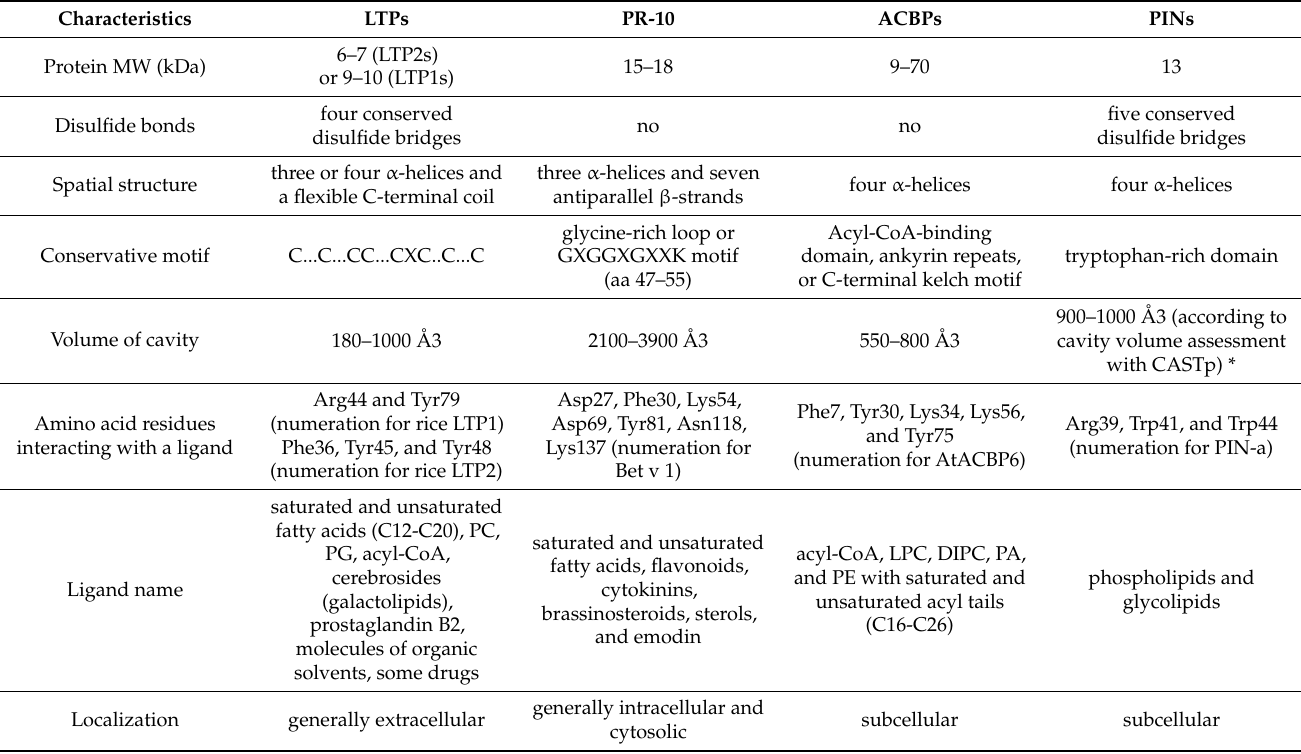
Table 1. Comparison of structure–functional properties of plant lipid-binding and transfer